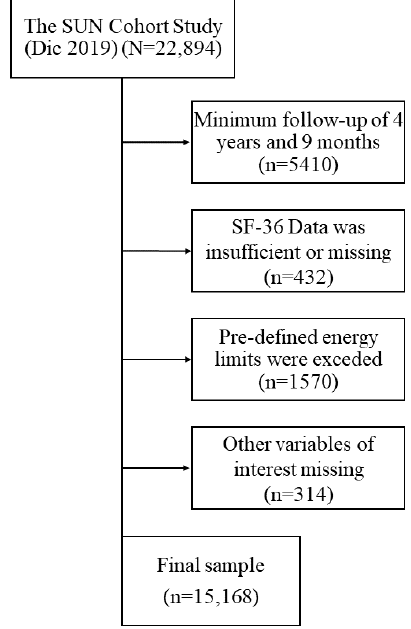
Figure 2. Final sample and exclusion criteria. Table 1. Baseline characteristics of participants categorized by Item 1 of the SF-36 (In general, would you say your health is).